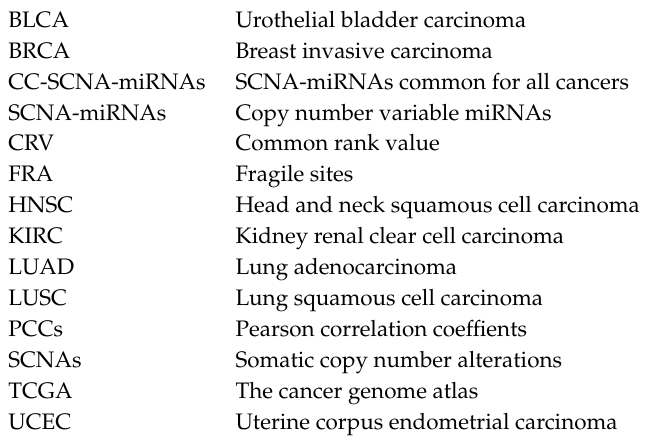
s1, Figure S1: The distribution of PCCs showing the correlation between the copy numbers and expression of 971 miRNAs in BLCA, BRCA, HNSC, KIRC, LUAD, LUSC, and UCEC samples. Figure S2: Scatter plots showing PCCs between miRNA copy numbers and expression levels across miRNA copy numbers for each cancer type. Figure S3: Distribution of PCCs showing a correlation between randomly permuted copy number values and miRNA expressions. Figure S4: Uncropped gel images for data in Figure 6. Figure S5: Scatter plots showing PCC between miRNA and mRNA expression levels according to miRNA expression. Table S1: Analysis of patient survival according to copy numbers of the 84 pairs of SCNA-miRNAs and cancer types. Table S2: Comparison of survival times between the groups with SCNA-miRNAs and other miRNAs according to miRNA copy numbers. Table S3: miRNAs commonly correlated with SCNAs across seven cancer types. Table S4: Univariate analysis of clinical factors and miRNAs to examine prognostic factors associated with cancer. Variables differ depending on cancer types. Table S5: Multivariate analysis of clinical factors and miRNAs to examine prognostic factors associated with cancer. Table S6: Cancer-related miRNAs according to the HMDD. Table S7: SCNA-miRNAs reported in HMDD and the results of literature search demonstrating SCNA-miRNA associations with cancer development and